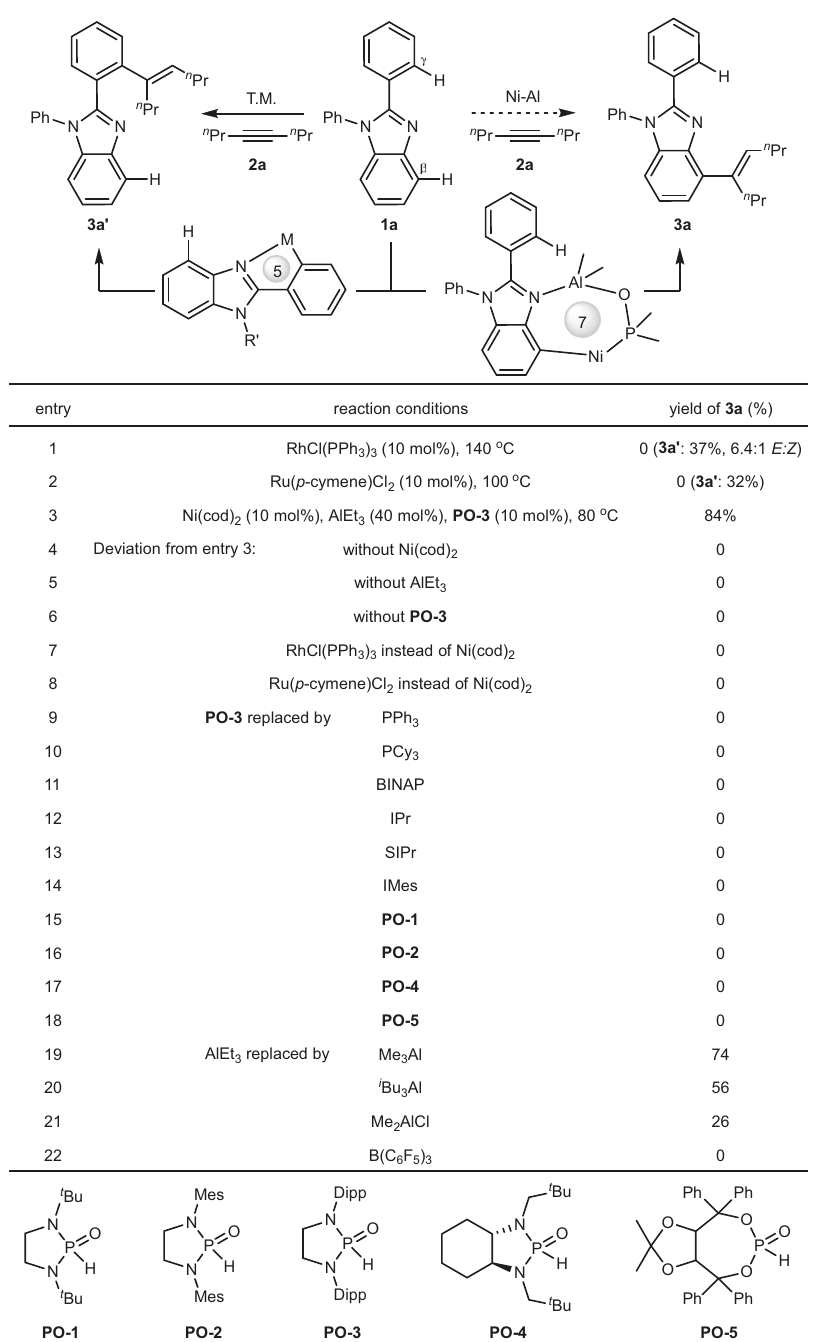
Fig. 2 Reaction optimization. Reaction conditions: 1a (0.2 mmol), 2a (0.4 mmol), AlEt 3 (1 mol/L in hexane, 0.08 mmol), toluene (0.4 mL) under N 2 for 12 h. Yield was determined by 1 H NMR. cod = 1,5-cyclooctadiene. Et = ethyl. Cy 3 P = triisopropylphosphine. BINAP = 2,2 ’ -bis(diphenylphosphino)-1,1 ’ - binaphthalene. IPr = 1,3-bis(2,6-diisopropylphenyl)-2,3-dihydro-1 H -imidazole. SIPr = 1,3-bis (2,6-diisopropylphenyl)imidazolidine. IMes = 1,3-dimesityl- 2,3-dihydro-1 H -imidazole. i Bu = isobutyl. t Bu = tert -butyl. Mes = 2,4,6-trimethylphenyl. Dipp = 2,6-diisopropylphenyl. NATURE COMMUNICATIONS| (2022) 13:2938